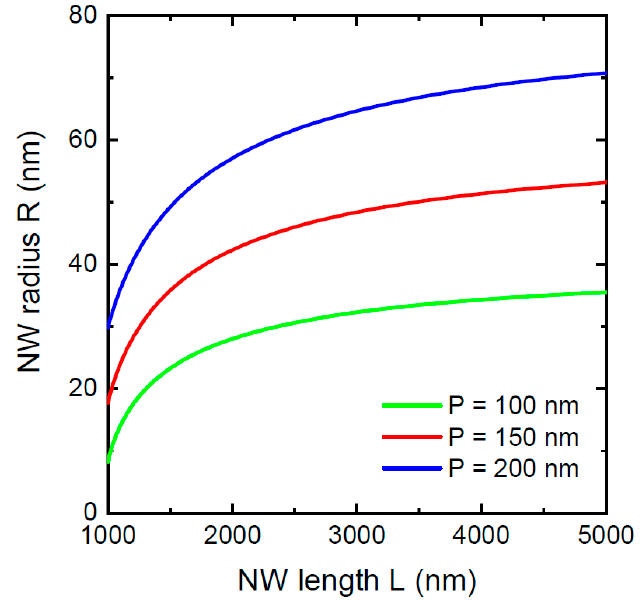
Figure 1. Evolution of the NW radius with length in the asymptotic growth stage, obtained from Equation (17) at a fixed 𝐿 1 , and 𝛽 (cid:3404) 130°, and three different pitches 𝑃 shown in the legend.